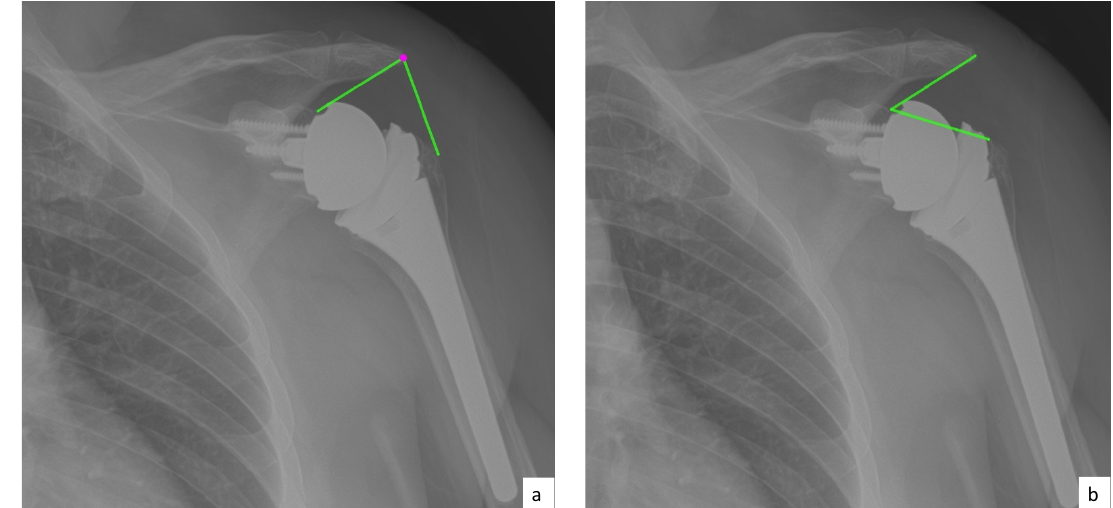
Figure 3. ( a ) Lateralization shoulder angle (LSA); ( b ) distalization shoulder angle (DSA).